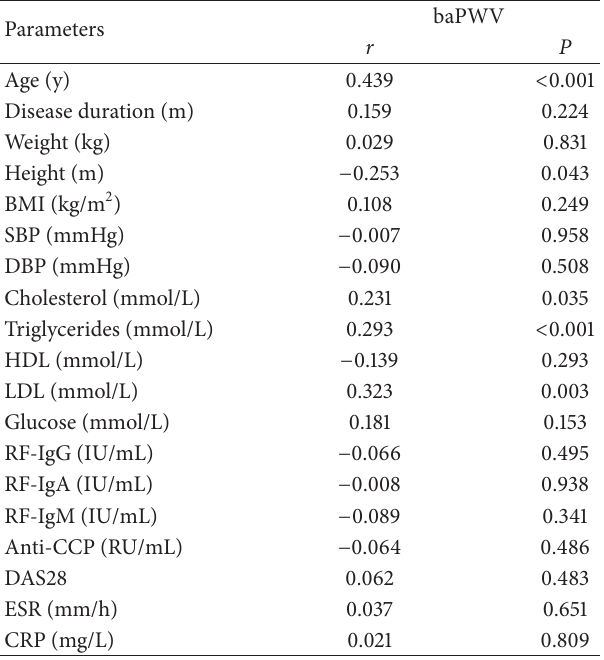
Table 4: The correlations between baPWV and other